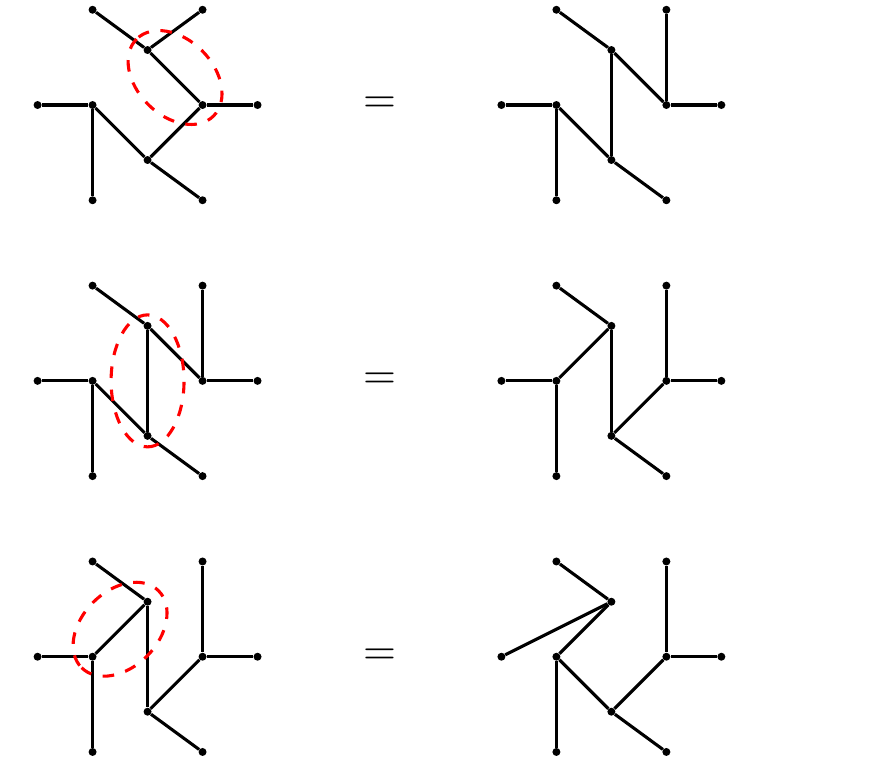
Figure 2 . Associativity properties of four-point correlation functions linking the two di(cid:11)erent representations of the six-point correlation function of (cid:12)gure